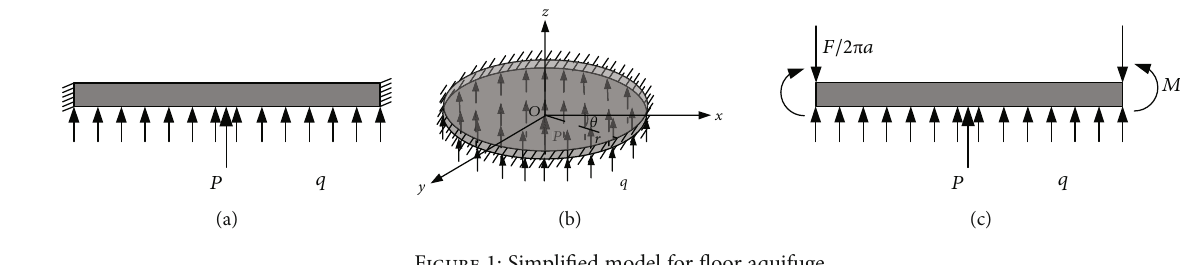
Figure 1: Simpli fi ed model for fl oor aquifuge.